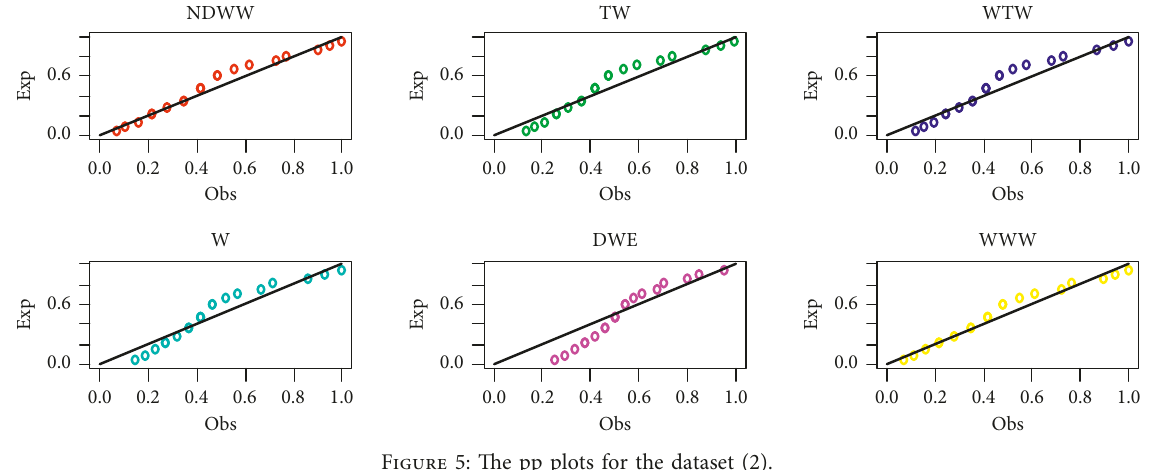
Figure 5: The pp plots for the dataset (2).